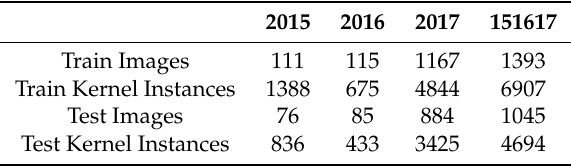
Table 1. Overview of datasets created based on the year in which the images were captured. The total number of images and kernel instances per dataset is